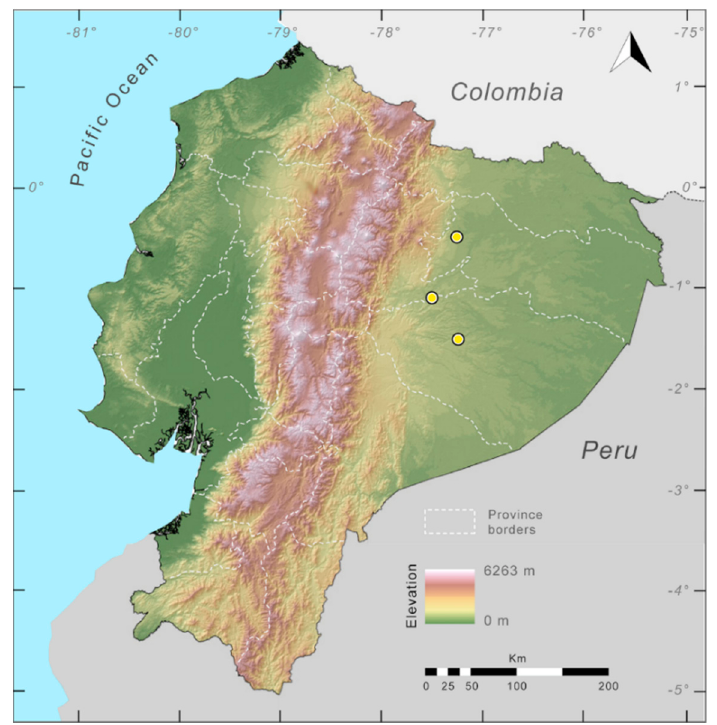
Figure 126. Distribution of Hyalinobatrachium yaku in Ecuador (yellow dots).